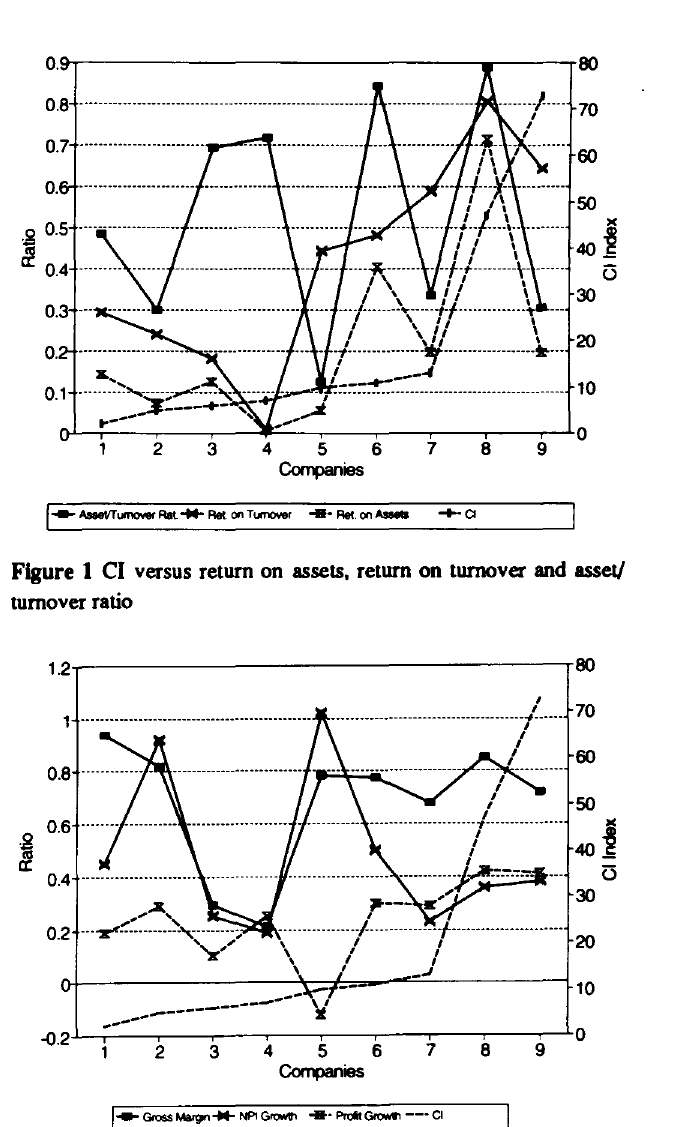
Figure 1 CI versus return on assets, return on turnover and asset/